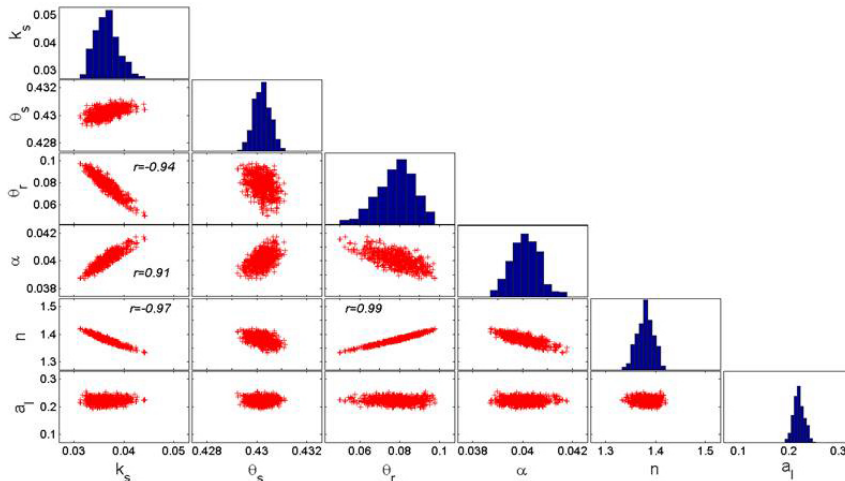
Figure 4. MCMC solutions for transport scenario 3 (see Fig. 2 caption).